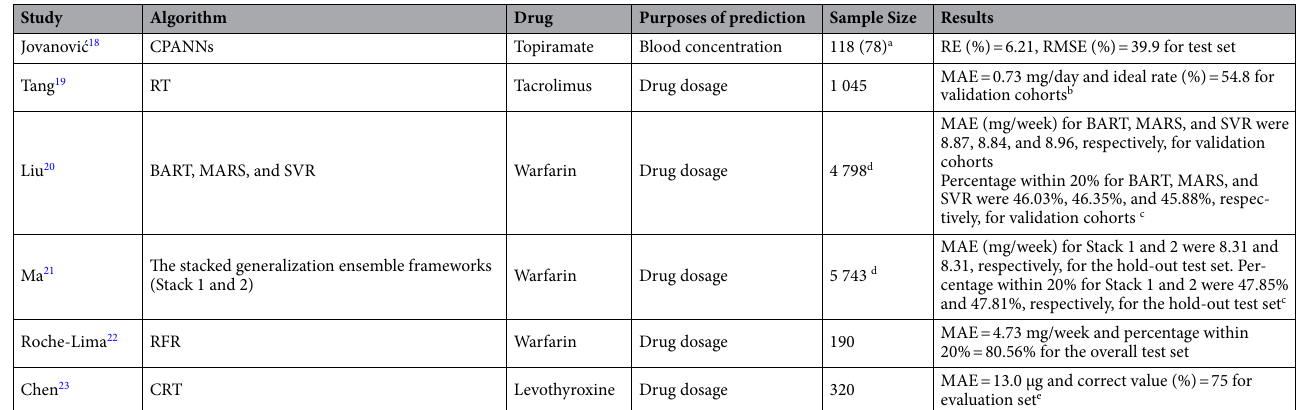
Table 1. Summary of several relevant studies on models to predict either drug dosage or blood concentration. CPANNs counter-propagation artificial neural networks, RT regression tree, BART Bayesian additive regression trees, MARS multivariate adaptive regression splines, SVR support vector regression, RFR random forest regression, CRT classification and regression tree, RE relative error, RMSE root mean squared relative error, MAE mean absolute error. a Therapeutic drug monitoring (TDM) measurements, with the number of patients in the parentheses. b The ideal rate was defined as the percentage of patients for whom the predicted doses were within 20% of the actual stable therapeutic doses of tacrolimus. c The percentage within 20% was defined as the percentage of patients for whom the predicted doses were within 20% of the actual stable therapeutic doses of warfarin. d Data was obtained from the International Warfarin Pharmacogenetics Consortium (IWPC) open access dataset. e The correct value (%) was defined as the percentage of patients for whom the predicted dose adjustment correctly fell within the smallest increment in doses of levothyroxine (12.5